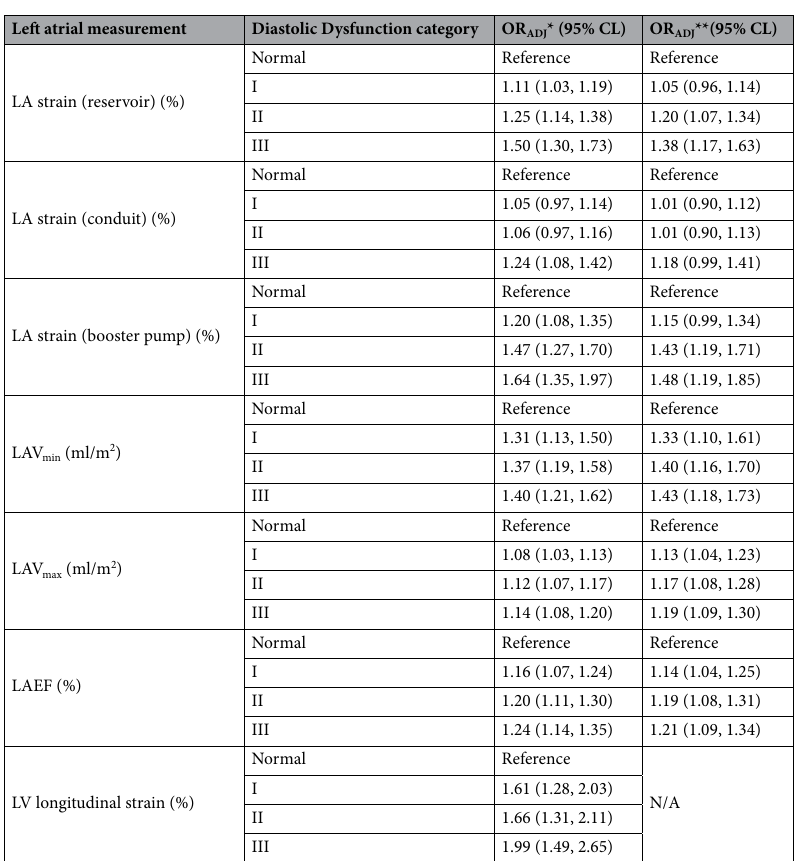
Table 3. The association between change in LA features and worsening categories of left ventricular diastolic dysfunction. OR ADJ = adjusted odds ratio; 95% CL = 95% confidence limit; LAV max = left atrial maximum volume; LAV min = left atrial minimum volume; LAEF = left atrial emptying fraction. *Adjusted for age, gender, BSA (except in models with LAV max and LAV min ), diabetes, hypertension, and smoking. **Additionally adjusted for left ventricular global longitudinal